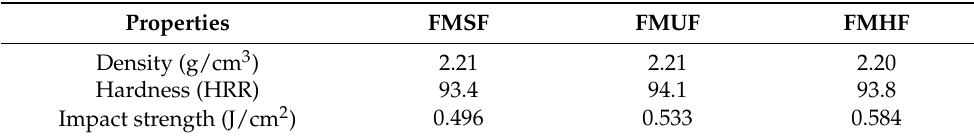
Table 4. Physical and mechanical properties of the tested composite